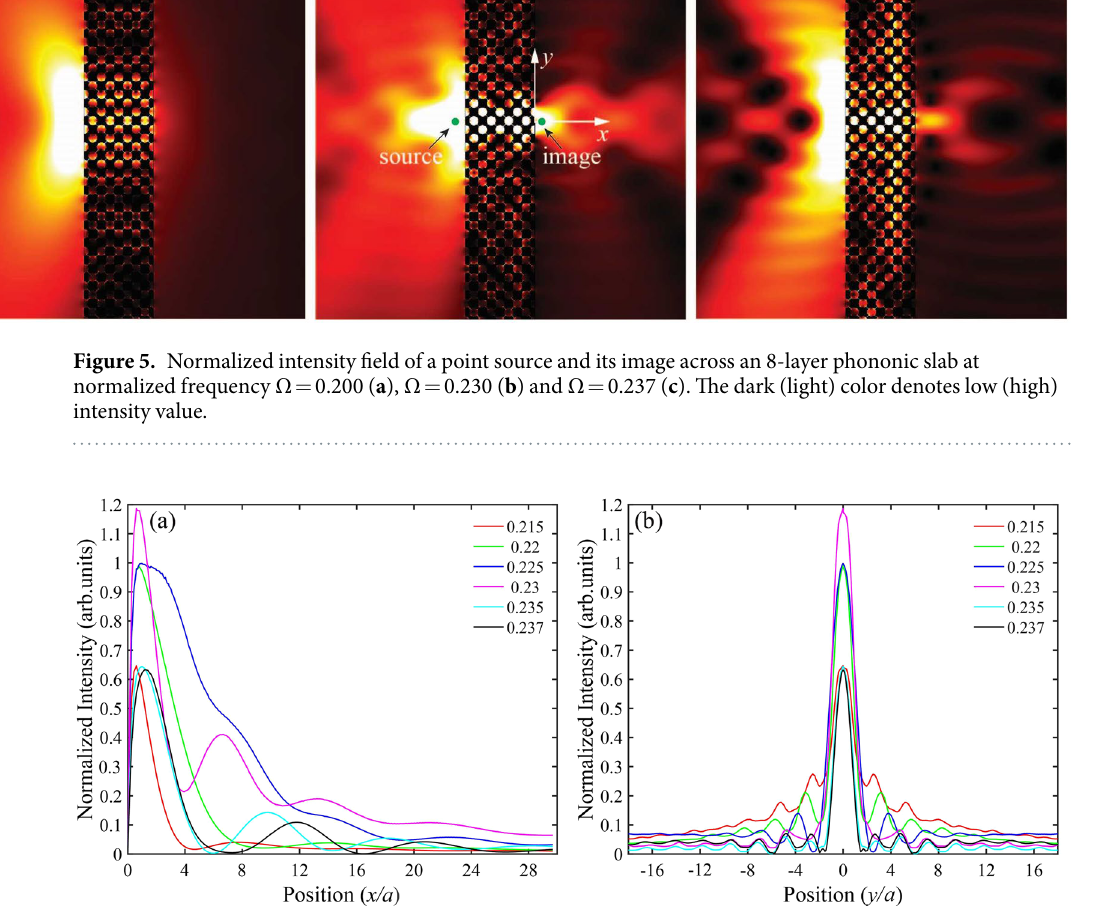
Figure 6. Normalized intensity distributions along the direction perpendicular ( a ) and parallel ( b ) to the phononic slab surface at different